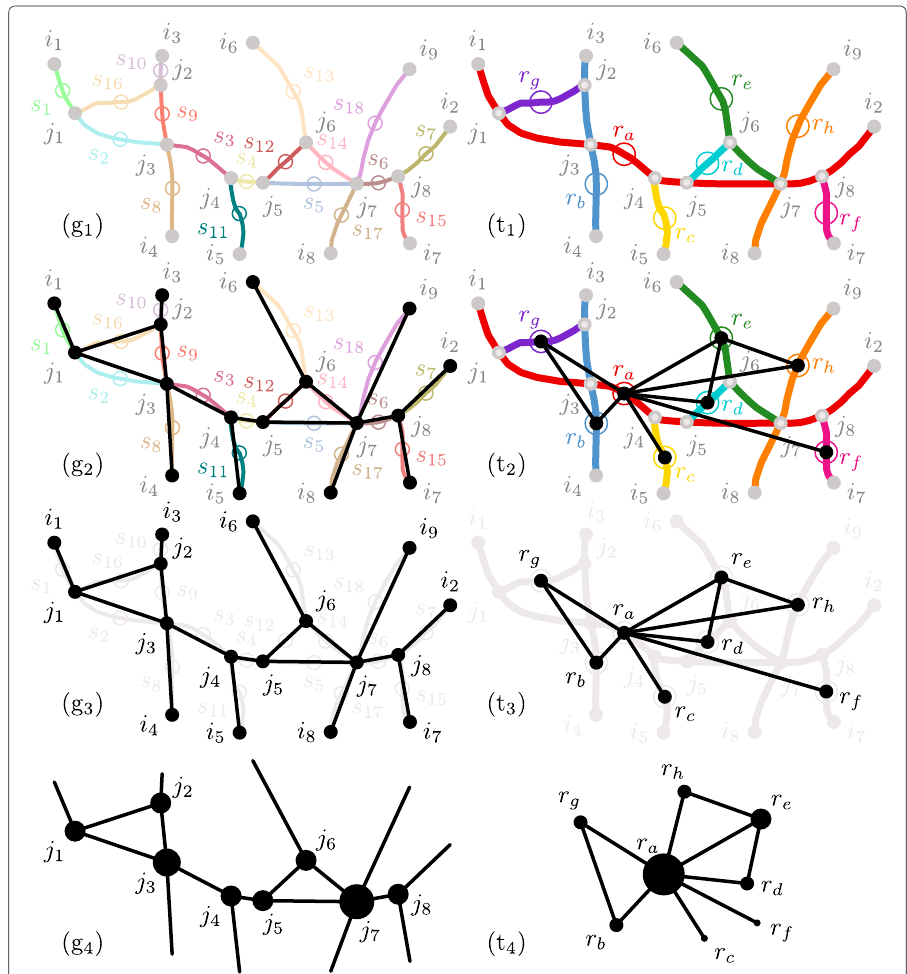
Fig. 2 Geometrical versus topological approaches for urban street networks: a four-step visual construction of their respective abstract networks. Each construction is performed on the notional sample exhibited in Fig. 1. The left four-step sequence (g 1 )–(g 4 ) and its right counterpart (t 1 )–(t 4 ) sketch for this sample the geometrical and topological abstract network constructions, respectively. At Step 1, street-segments and roads are identified: the street-segments are labelled with indexed s and coloured in distinct pallid colours; the roads are labelled with indexed r and coloured in distinct vivid colours. Meanwhile, the junctions and the impasses are coloured in grey and labelled with indexed j and i , respectively. In Subfigure g 2 , the extended junctions j ∗ and i ∗ and the street-segments s ∗ spontaneously become nodes and edges, respectively. In Subfigure t 2 , each road r ∗ is reduced to a node and each road-node pair { r ∗ , r (cid:2) } is linked whenever r ∗ and r (cid:2) share at least a common junction. At Step 3, the raw material is being dissolved to highlight the